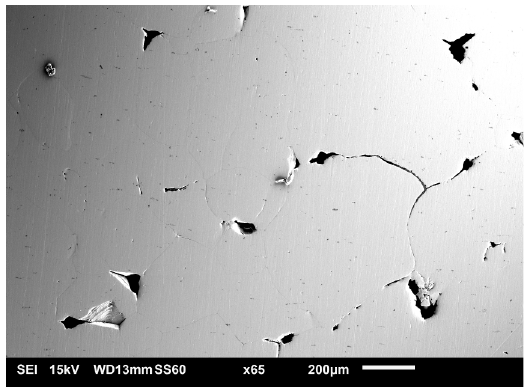
Table 3. Parameters obtained from the potentiodynamic polarization test.